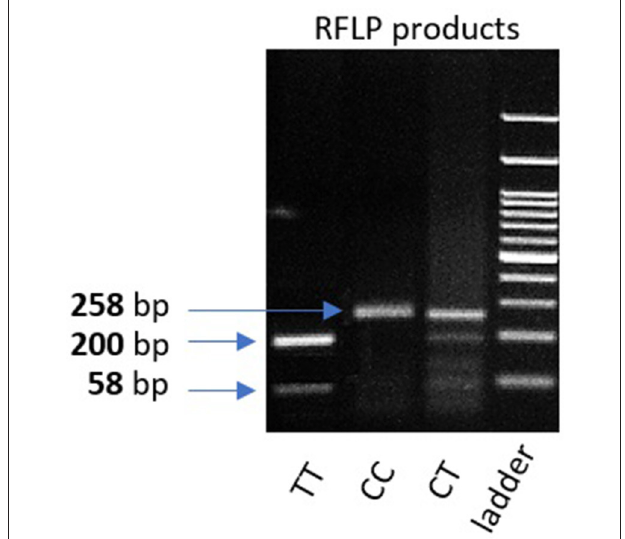
FIGURE 2 | 2% gel representing PCR fragments of VDR fok1 genotypes using RFLP PCR. Lane 1: The homozygous mutant type (TT) cut at one site giving 2 bands (200 and 58 bp). Lane 2: Homozygous wild type (CC) uncut, (258 bp). Lane 3: Heterozygous (CT) genotype having 3 bands (258, 200, 58 bp). Lane4: 100 bp DNA Ladder.